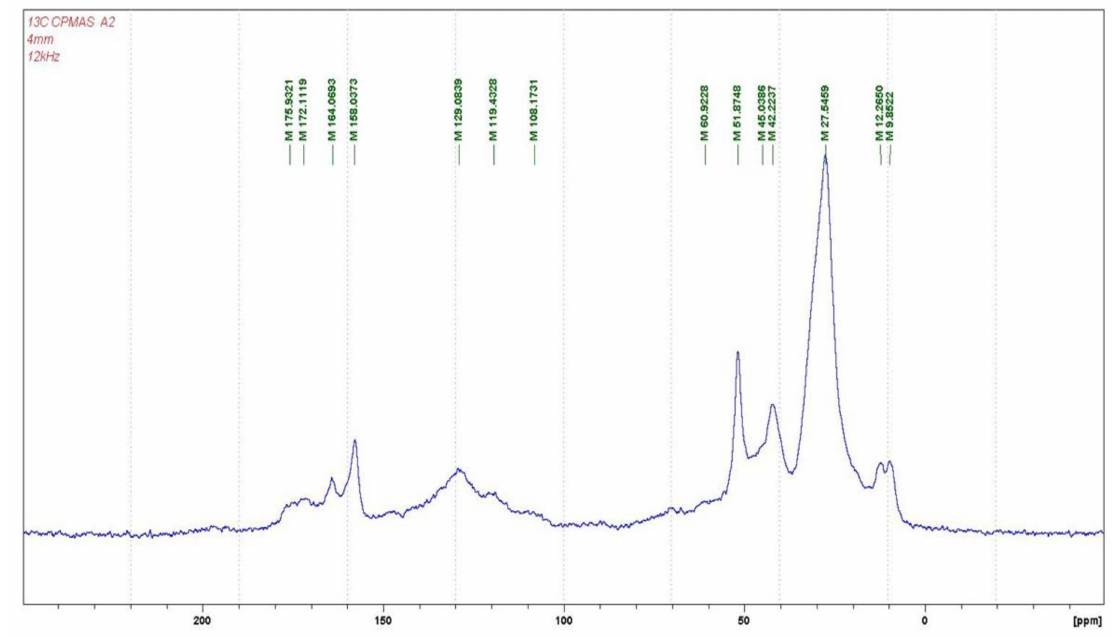
Figure 14. CP-MAS 13 C NMR spectrum of the A2 NIPU resin.